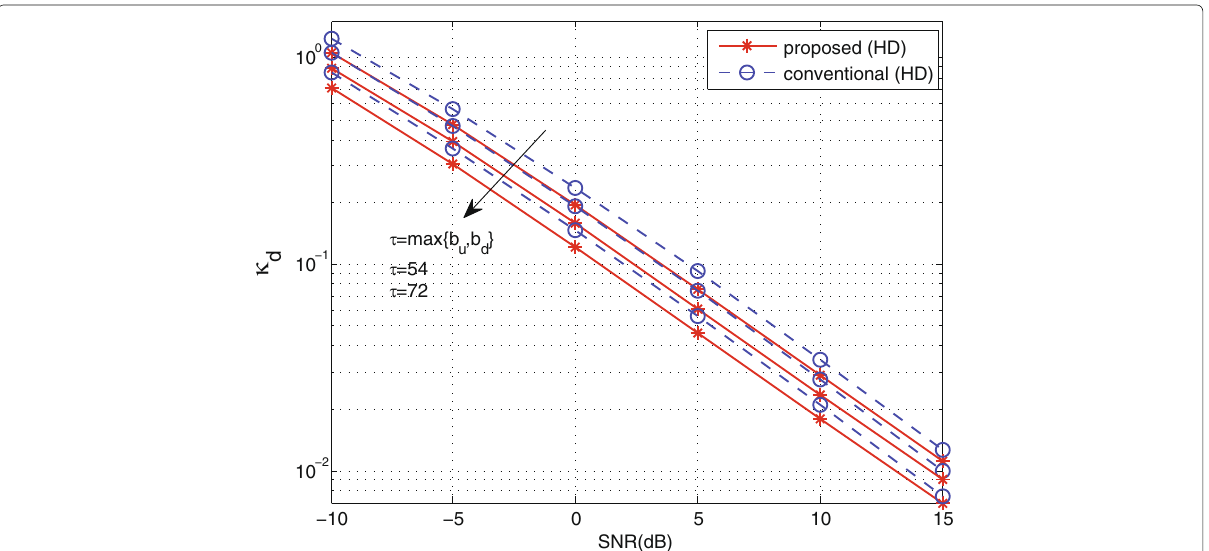
Fig. 5 Comparison of the DL channel estimation performance between the beamspace channel estimation and conventional estimation versus average receive